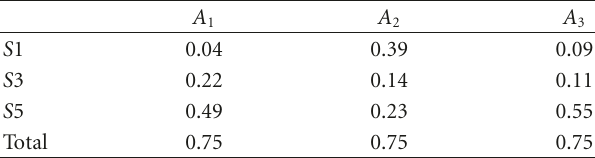
Table 14: Load factors in the